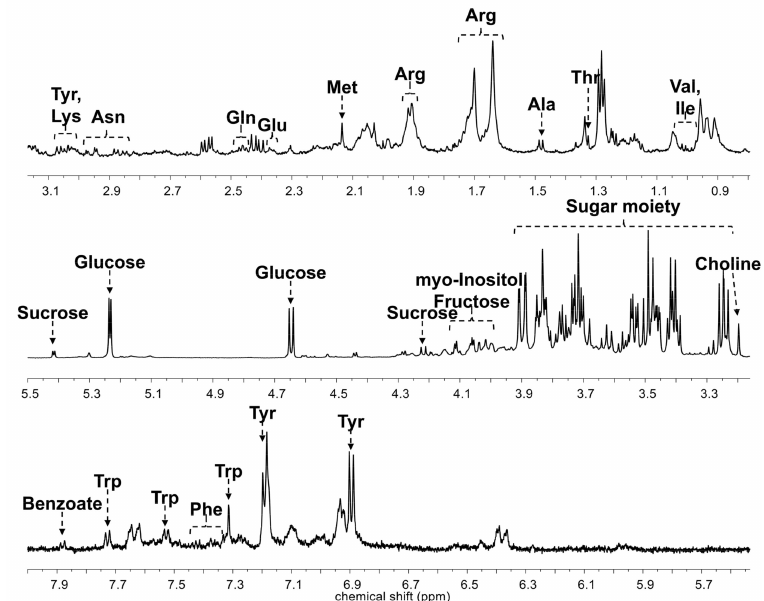
Figure 4. Representative 1 H-nuclear magnetic resonance (NMR) spectrum with metabolite annotation. Ala, alanine; Arg, arginine; Asn, asparagine; Gln, glutamine; Glu, glutamate; Ile, isoleucine; Lys, lysine; Met, methionine; Phe, phenylalanine; Thr, threonine; Trp, tryptophan; Tyr, tyrosine; Val,